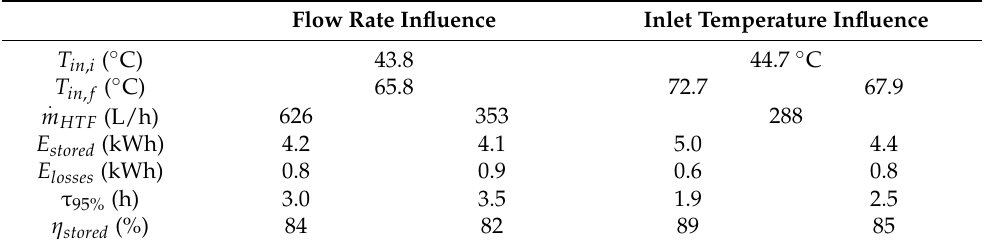
Table 5. Flow rate and inlet temperature influence on the TES storage time and